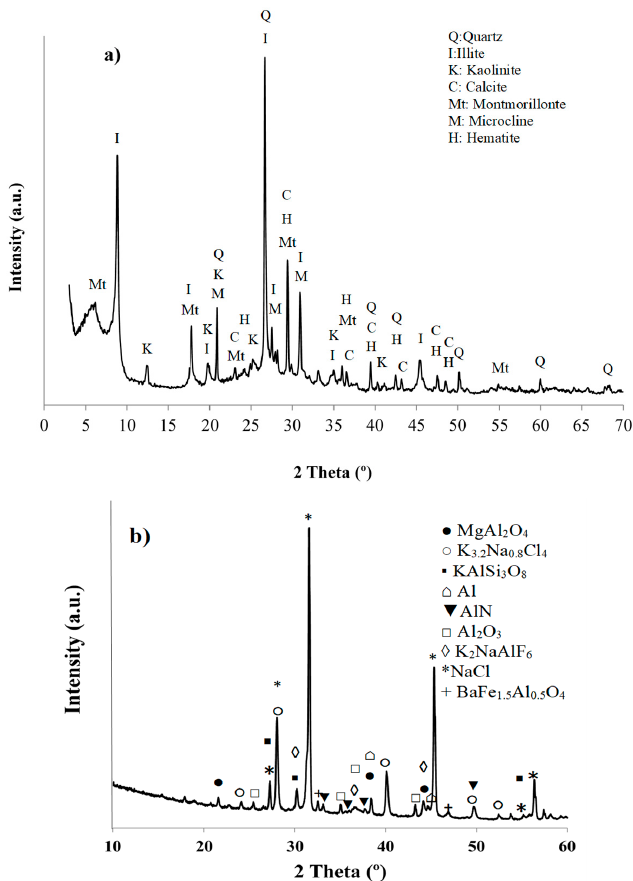
Figure 2. XRD pattern of ( a ) raw clay and ( b ) AFD waste.